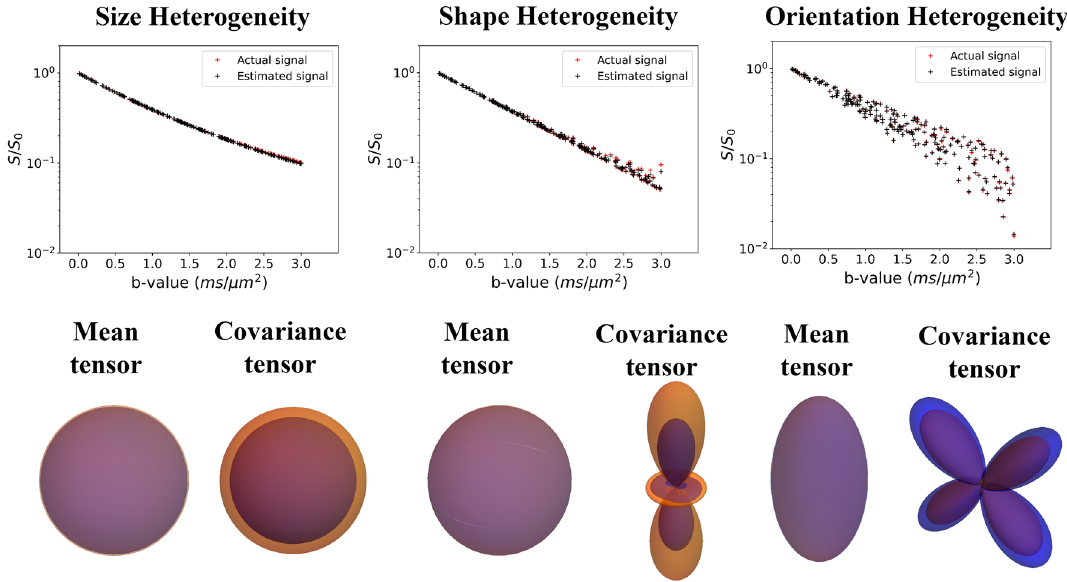
Figure 5. Estimation of mean and covariance tensors from synthetic MR signal without noise. The estimation is shown for three different DTDs (isotropic emulsion, shape heterogeneous and crossing fiber type DTDs) shown in Figs. 2 and 3. The signal curve using the proposed model obtained from actual and estimated mean/ covariance tensors is shown in the first row. The mean and covariance glyphs for actual (orange) and estimated (blue) DTD are overlaid and shown in the second row. The above graphics was generated using the matplotlib package 68 , and the Mathematica software 67 .